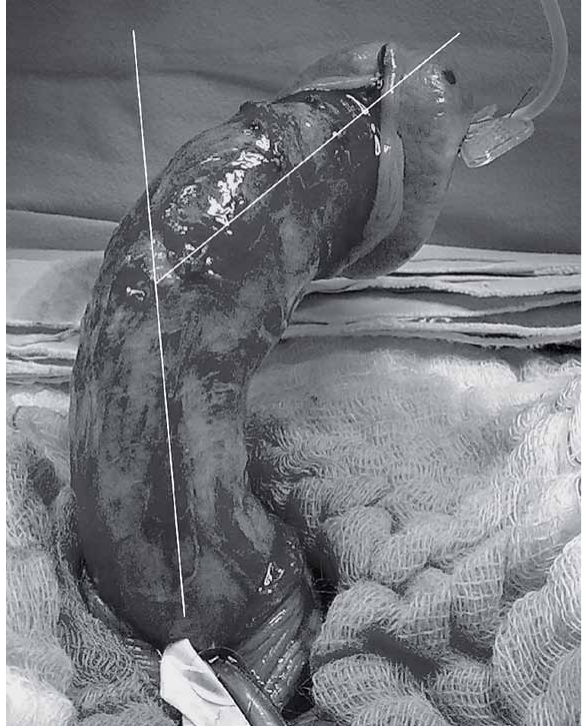
Figure 3 - It is necessary to detach neurovascular bundle or urethra to permit the access to the Peyronie’s plaque.